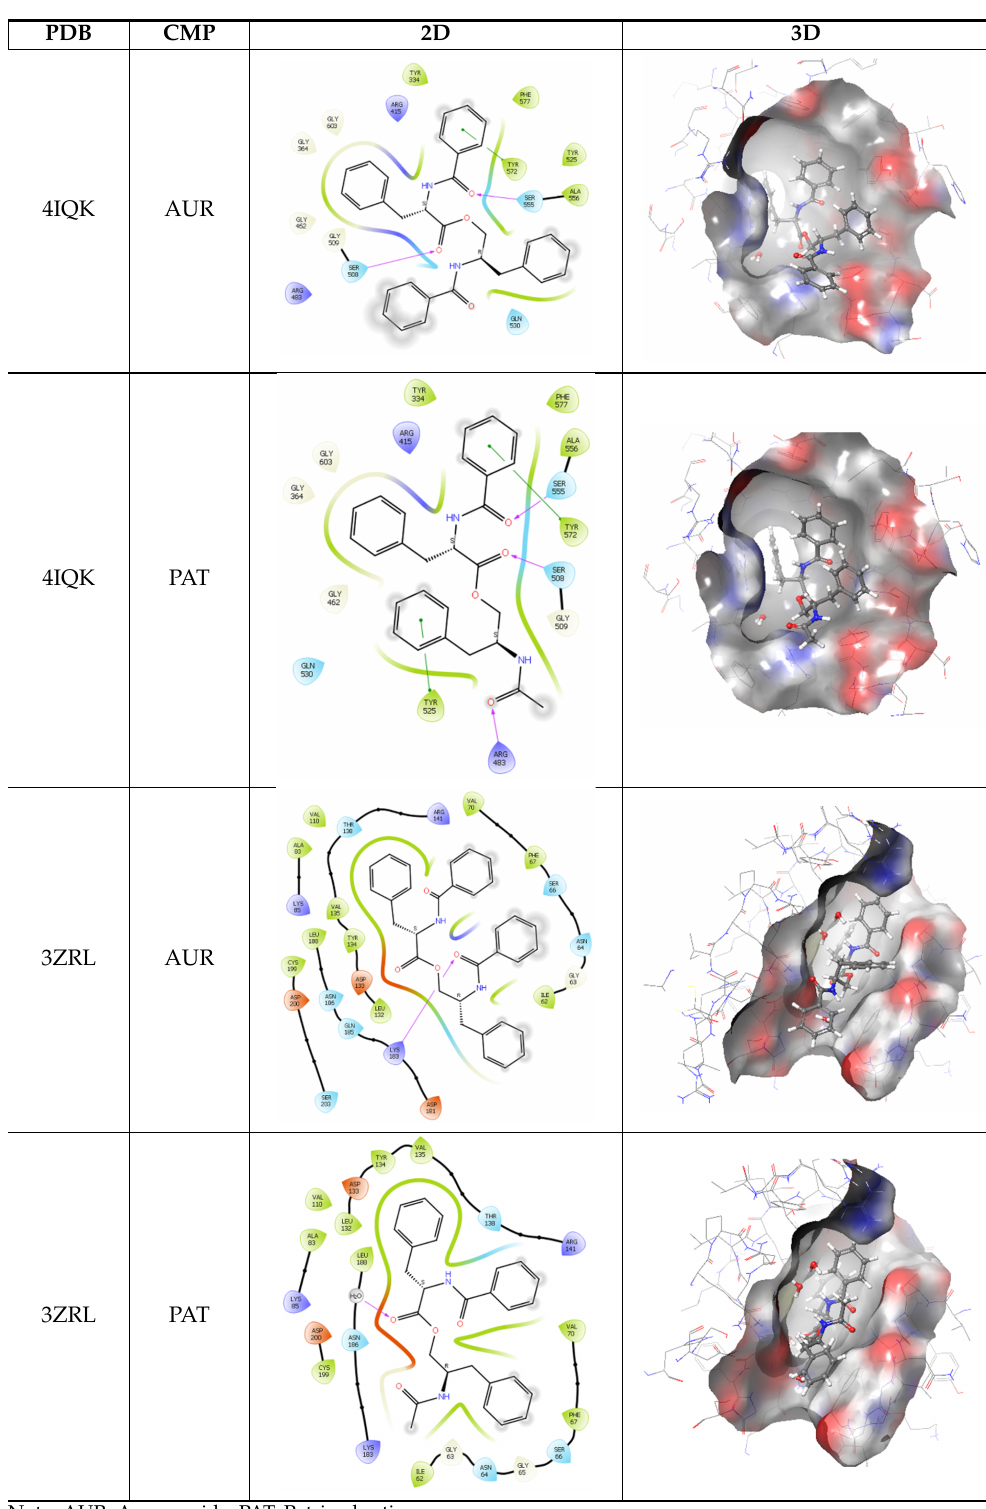
Table 2. The two-dimensional (2D) and three-dimensional (3D) images of docking studies of